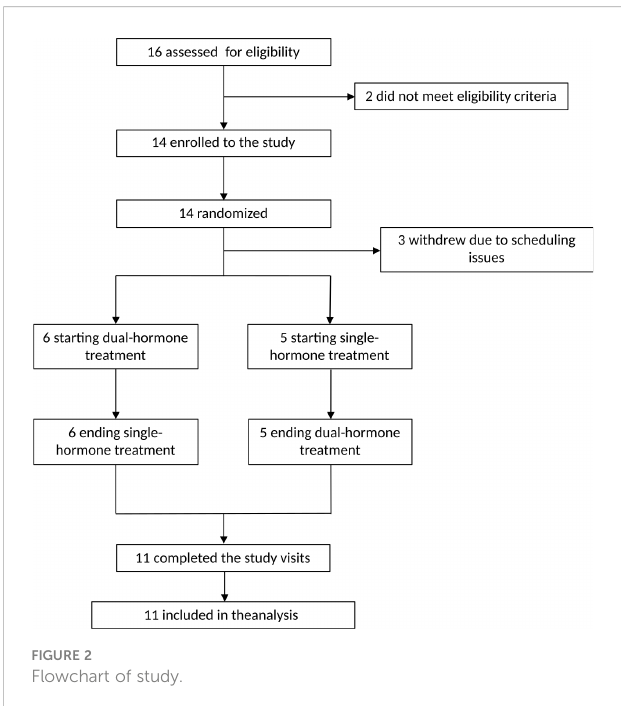
FIGURE 2 Flowchart of study.